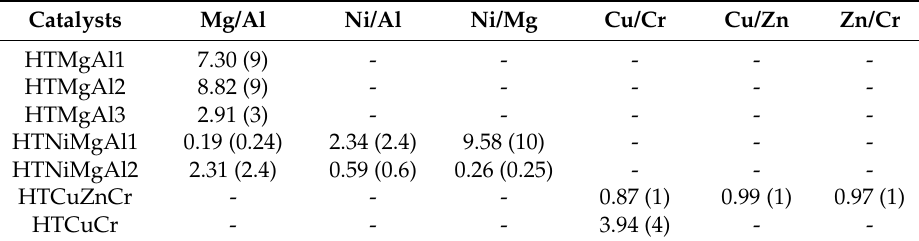
The values between parentheses correspond to the theoretical values. 214